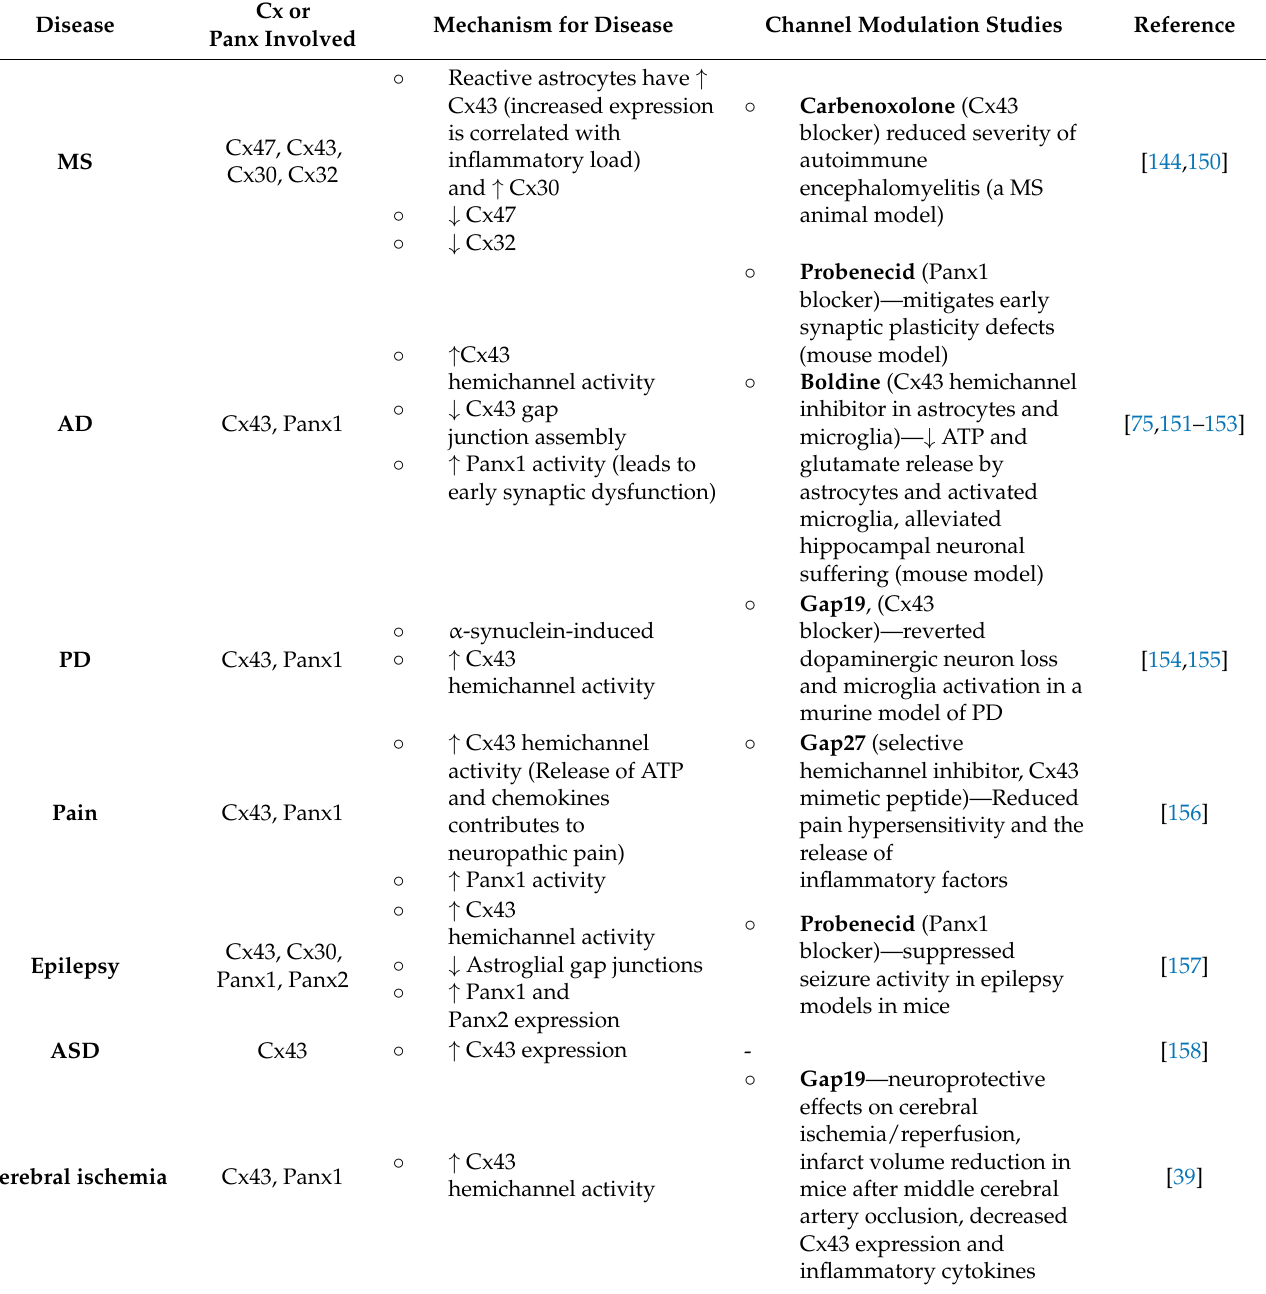
Table 3. Acquired diseases associated with Cx and Panx expression, related mechanisms for disease, and available studies on pharmacological